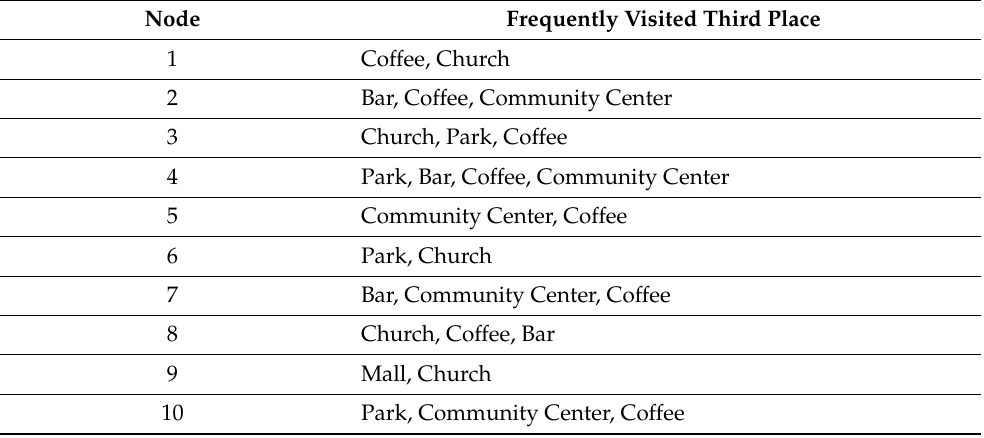
Table 5. Simulate attributes of nodes.